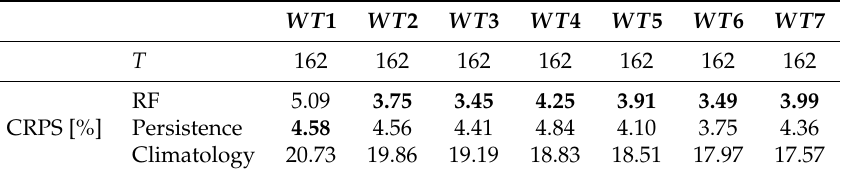
Table 2. Average continous ranked probability score (CRPS) of five-minute ahead forecasts of power for the seven wind turbines evaluated, in the case of a reduced radar availability (Figure 12b). Results (in % of the nominal capacity ( P n )) are shown for the remote sensing-based forecasting (RF) model, persistence and climatology